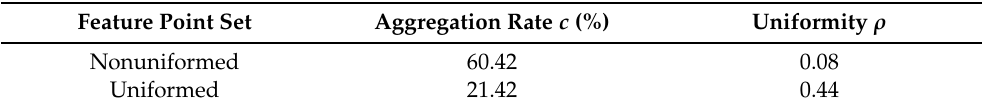
Table 1. Comparison of the aggregation rate and uniformity ( c and ρ ) of the nonuniformed and uniformed feature point